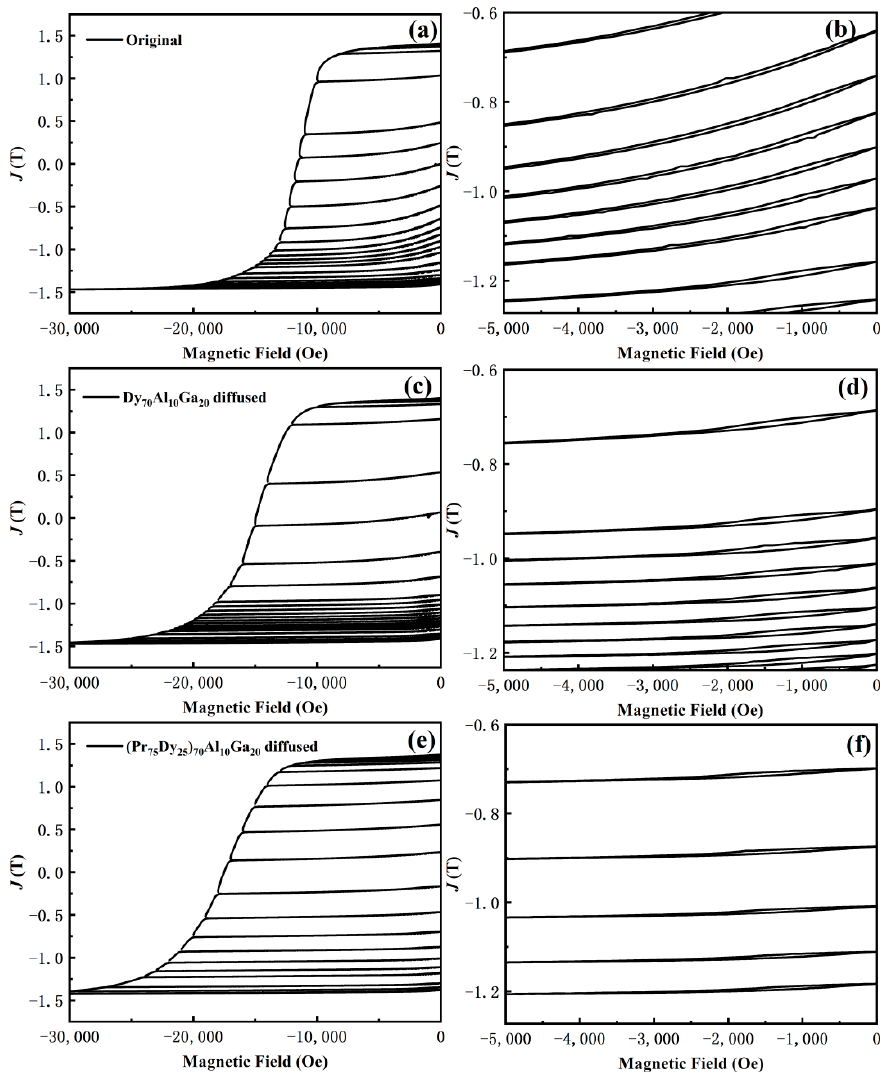
Figure 10. Recoil loops for ( a , b ) original magnets, and ( c , d ) Dy 70 Al 10 Ga 20 and ( e , f ) (Pr 75 Dy 25 ) 70 Al 10 Ga 20 alloy diffused magnets. ( e , f ) (Pr 75 Dy 25 ) 70 Al 10 Ga 20 alloy diffused